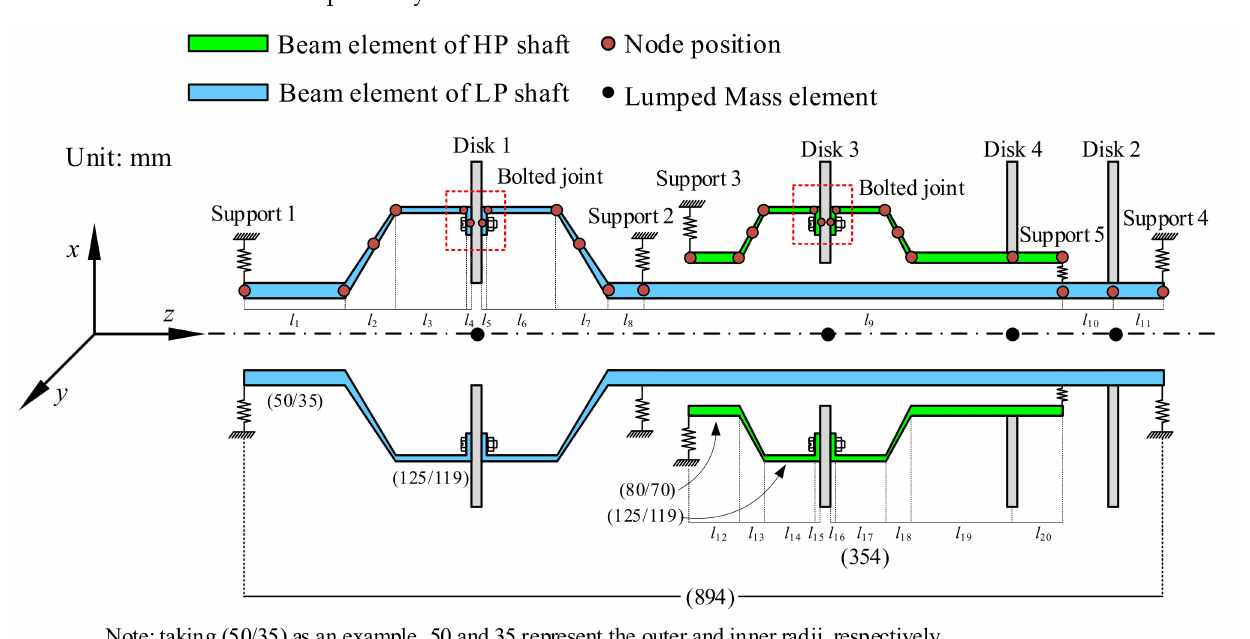
Figure 1. Finite element model of a dual-rotor system with bolted